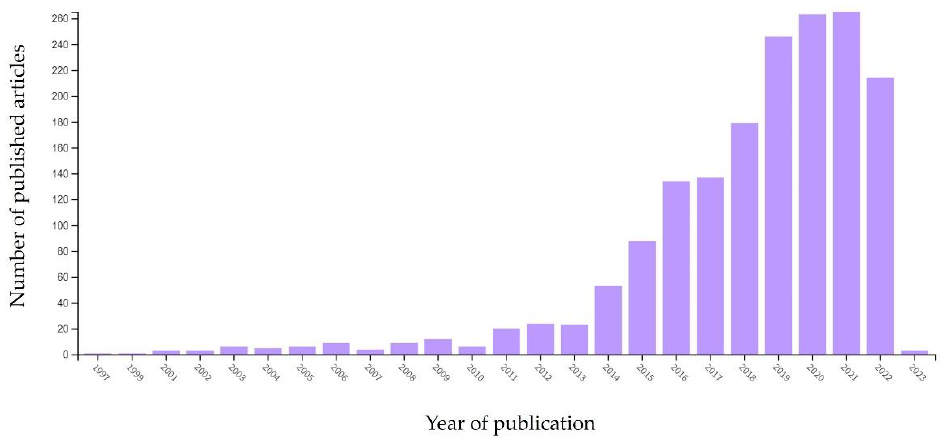
Figure 1. Growing trend of scientific publications using the keywords “3D printed microfluidic devices” according to Web of Science database [28].